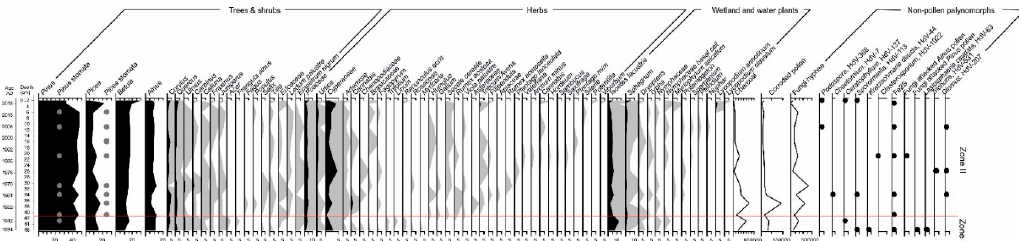
Figure 5. Pollen and non-pollen palynomorphs of Lake Sekšu. Trees, shrubs, herbs, crops, ruderal plants, bryophytes, and water plants expressed in percentages. Non-pollen palynomorphs and charcoal expressed as microscopic object accumulation rate cm − 2 year − 1 . Grey shaded areas indicate ×10 time exaggeration to underline the presence of microscopic remains.